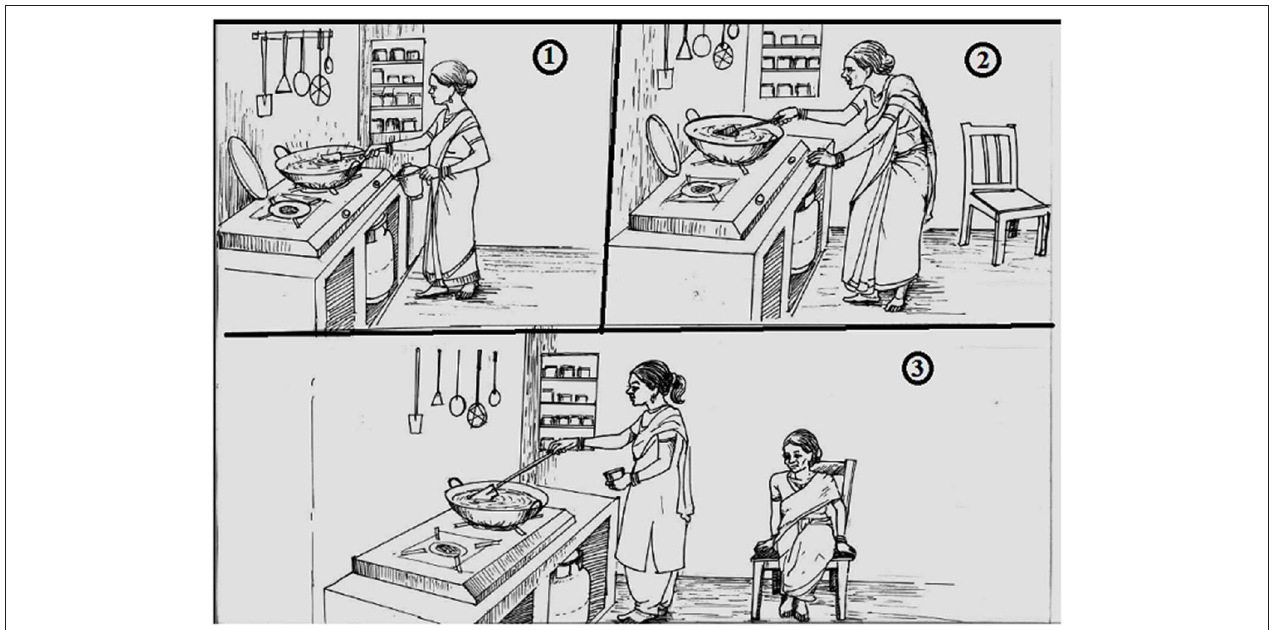
FIGURE 1 | Usual activity (third dimension) with the example of a homemaker, respectively with the three levels of severity: i.e., (1) no problem, (2) mild/moderate problem, and (3) severe problem. The figure depicts the third dimension (usual activity) and third severity level (severe problem) of a homemaker, who is unable to perform her usual activity of cooking and requires help.